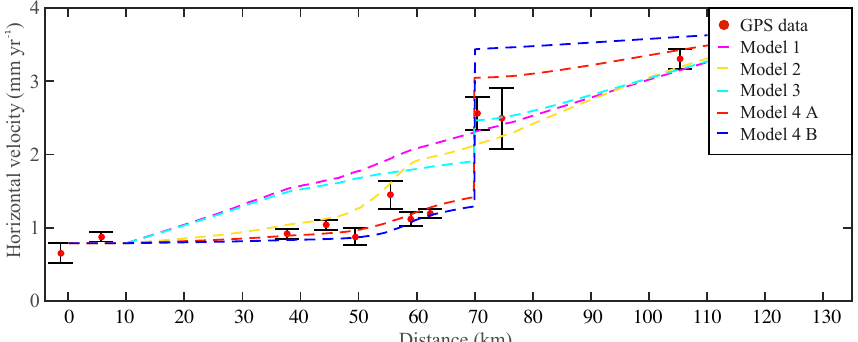
Figure 7. Horizontal velocity trend obtained for the different model settings. We calculate the weighted root mean squares (WRMS) in order to compare the results obtained from the numerical simulations with the GPS velocity observed. The best fit is obtained for Model 4A (see Table